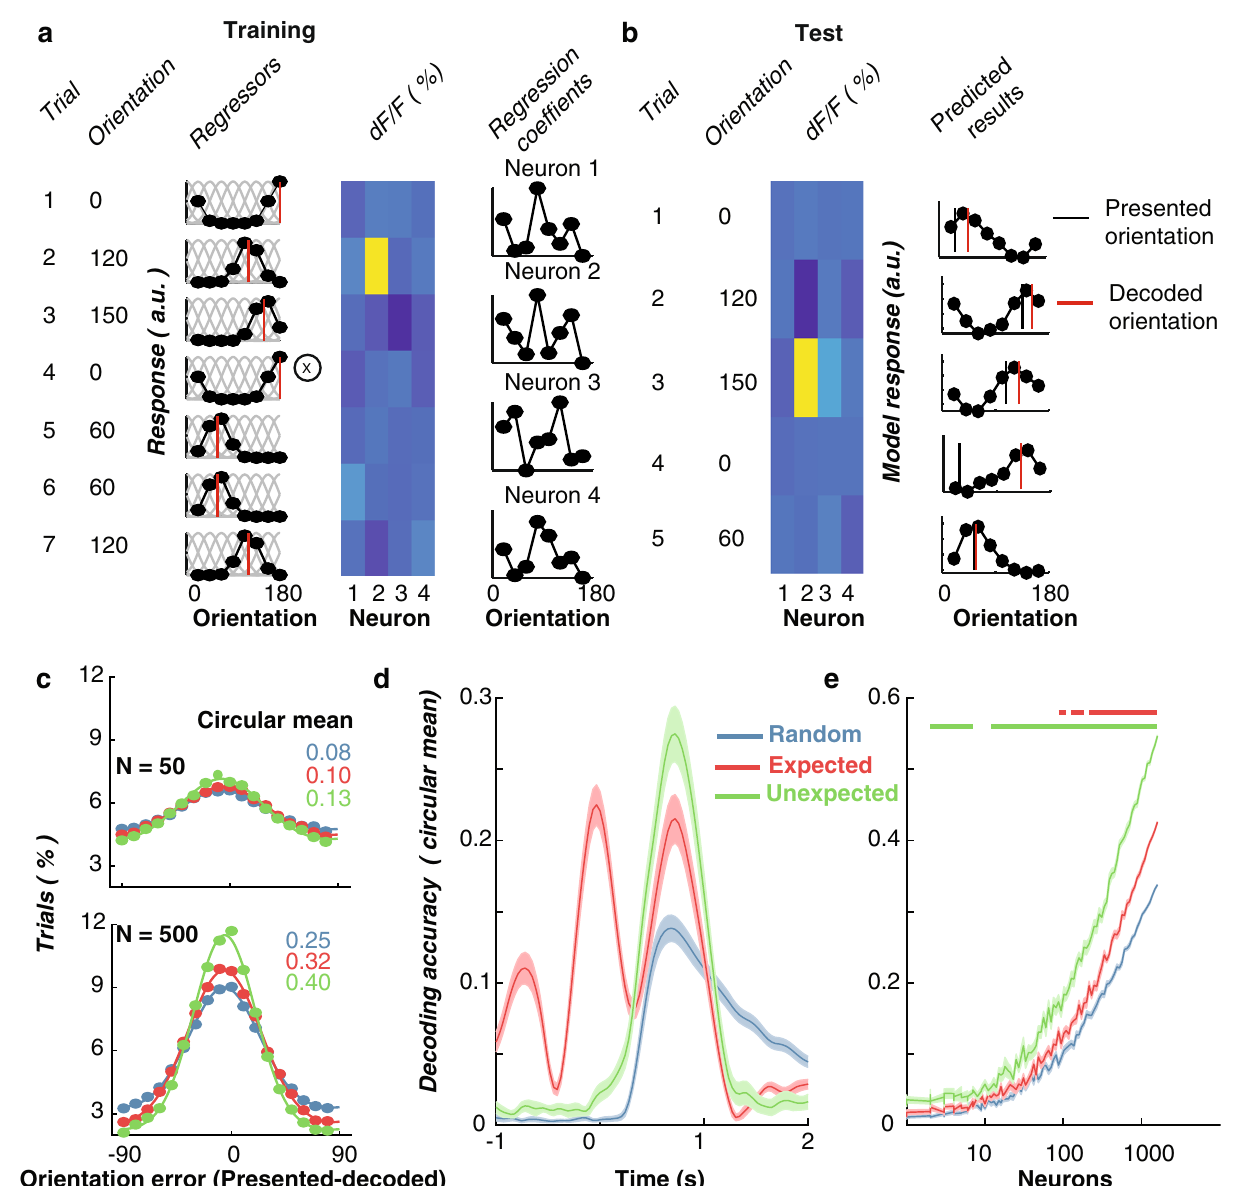
Fig. 3 | Expectation affects stimulus-speci fi c information carried by neuronal population activity. a Schematic of training the multivariate forward orientation encoding. Example regressors for 7 training trials with different orientations. The basisfunctions(greylines)inresponsetodifferentorientationswhichproducethe regressor weights. Neuronal response for four example neurons for the example trials. Least squared regression is applied between the regressors and response to determine selectivity. Regression coef fi cients (beta weights) for four example neurons for each of the regressors found from a training set of data. b Testing the encoding model.Activity for the four neurons in test trials. Inverting the regressor weights and multiplying them by the population responses from the four neurons produces the predicted orientation response from this pattern of activity. The differencebetweenthe predicted and presentedorientation for agivenstimulus is the orientation error. c Distribution of orientation error when encoding was